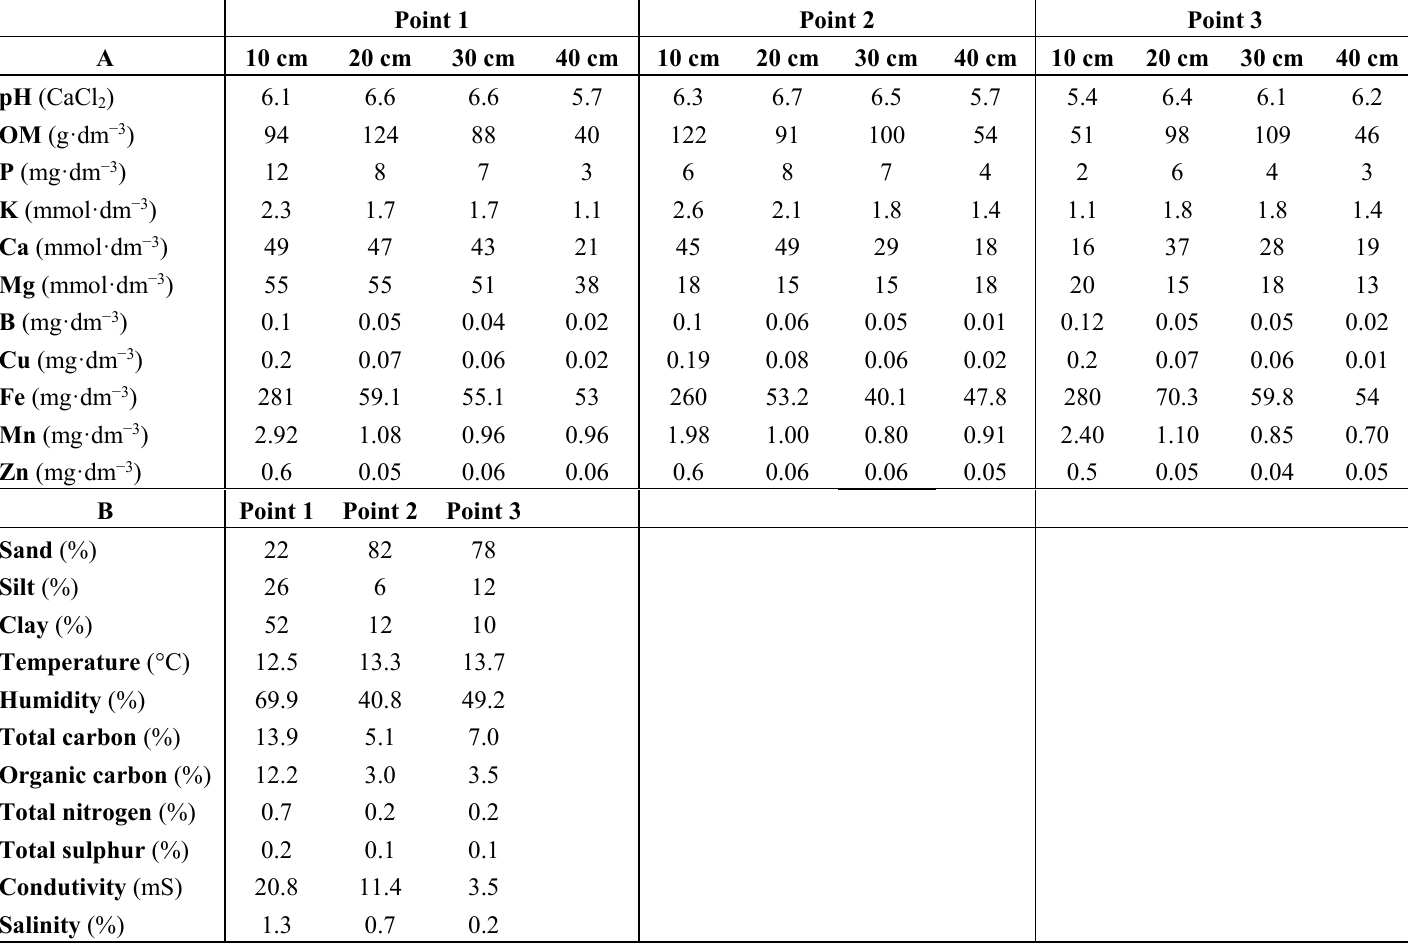
Table 1. Physicochemical properties of mangrove sediments sampled at different ( A ) depths and ( B ) points. Point 1 Point